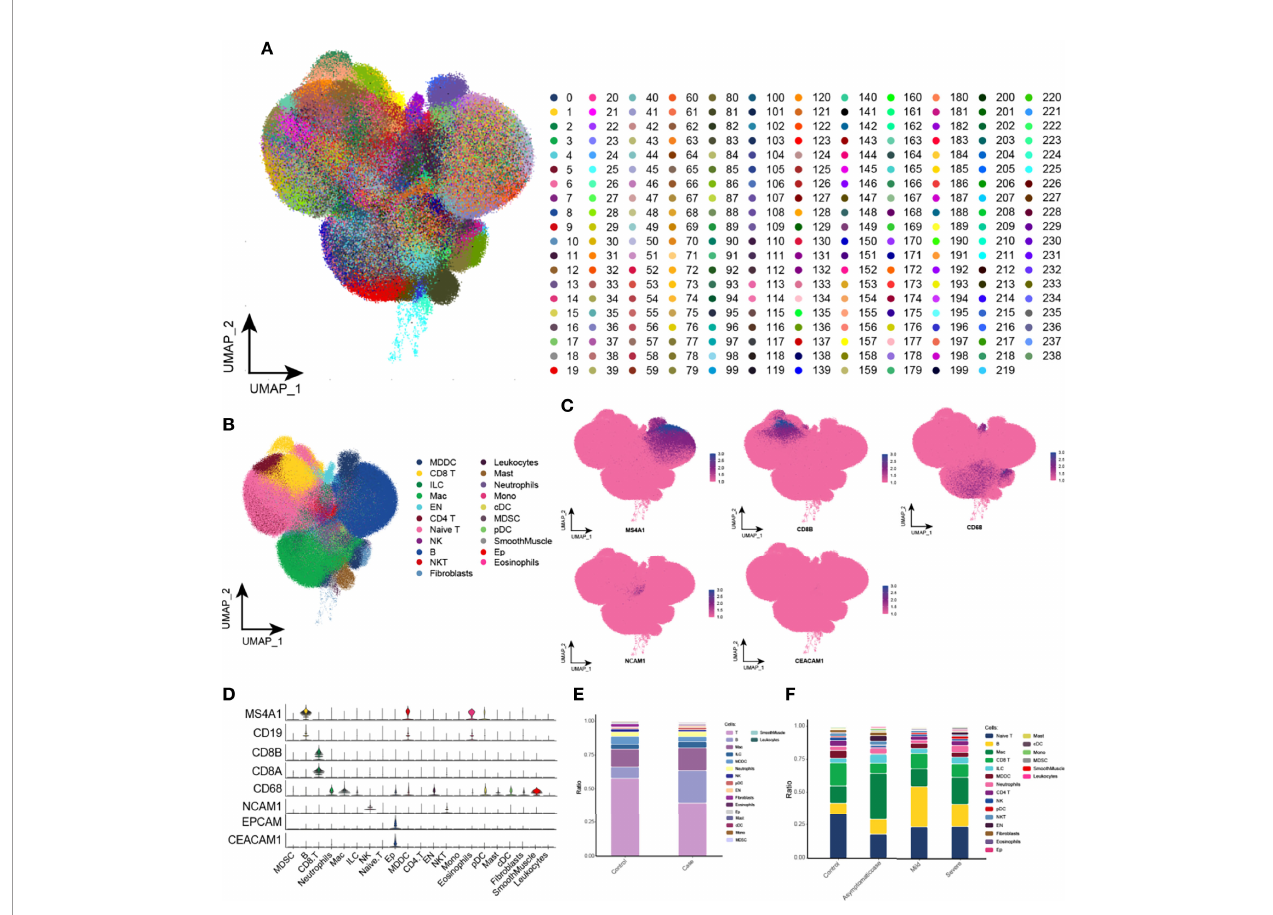
FIGURE 1 | Global single-cell spectrum of COVID-19. (A) Global single-cell spectrum of COVID-19, with a total of 1,529,428 cells and 239 clusters obtained. (B) A total of 239 clusters were divided into different cell types based on known marker genes. (C, D) clusters of cells with marker genes mapped in the single-cell spectrum of CD8 T cells (CD8A and CD8B), macrophages (CD68), NK cells (NCAM1), EP cells (EPCAM1 and CEACAM1), and B cells (MS4A1 and CD19). (E) Cytobiological components and changes in the healthy and COVID-19 groups. (F) Cytobiological components and changes in the healthy group and patients with COVID-19 with different courses (asymptomatic, mild, and severe). EP cell, epithelial cell; KEGG, Kyoto Encyclopedia of Genes and Genomes; NK cell, natural killer cell; UMAP, Uniform Manifold Approximation and Projection for Dimension